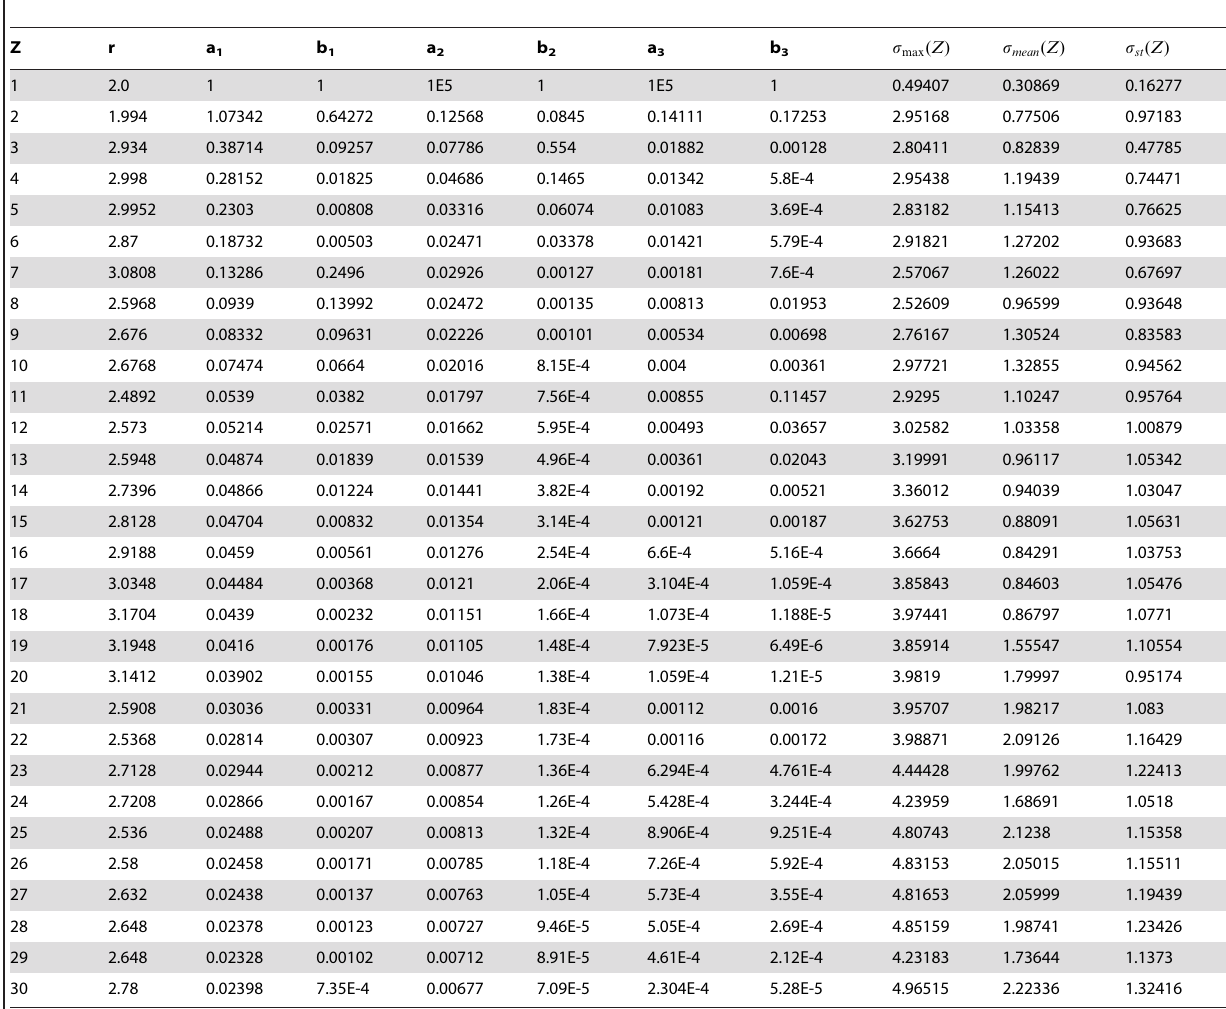
Table 1. Parameters of the function F H (q, Z) corresponding to Equation